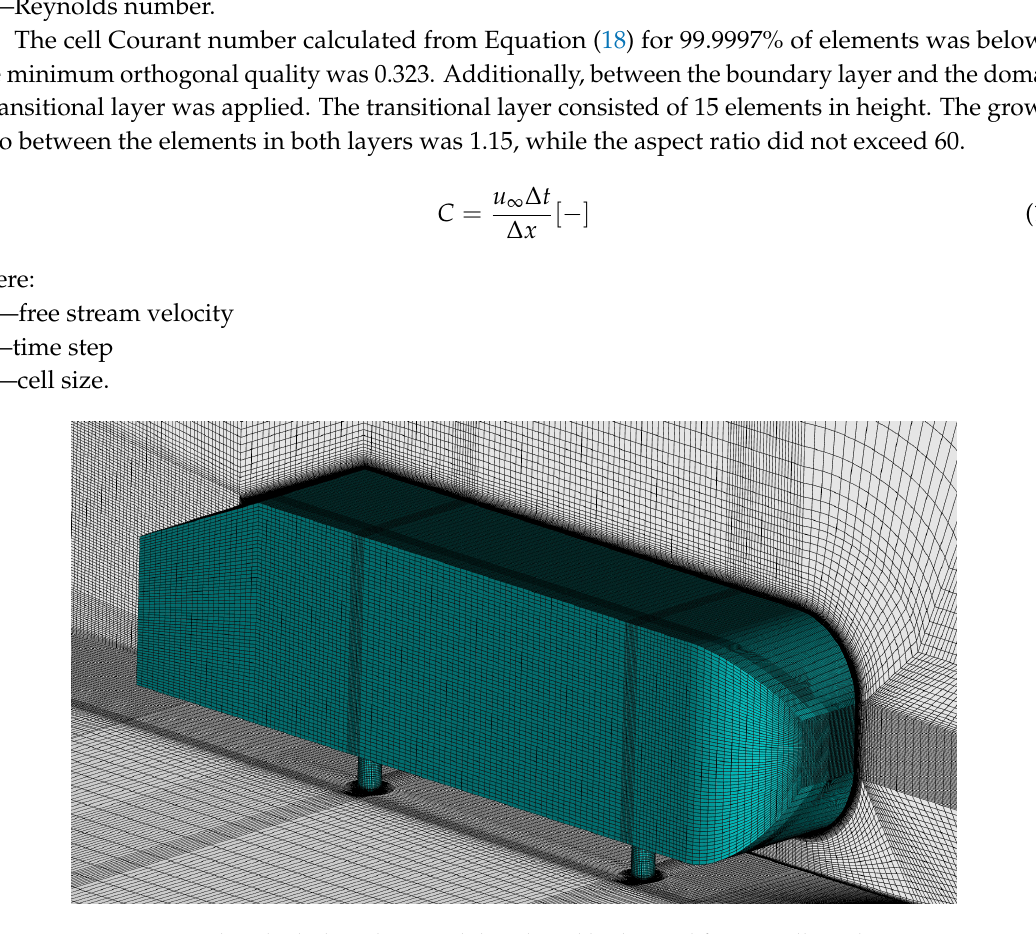
Figure 2. 3D hexahedral mesh around the Ahmed body. Grid for 5.1 million